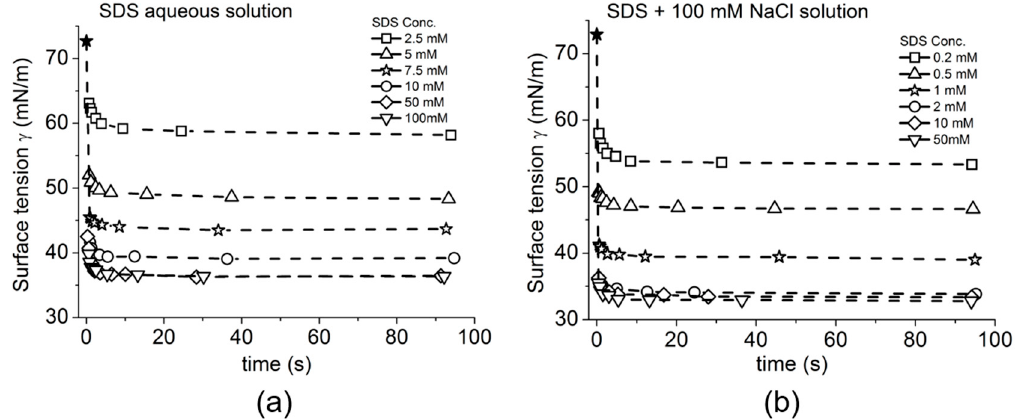
Figure 15. Dynamic surface tension of SDS in aqueous solution and in 100 mM NaCl solution measured by the MIAM at 20 ◦ C. ( a ) SDS adsorption in aqueous solutions for SDS concentrations from 2.5 to 100 mM made up in milli-pure water. ( b ) SDS adsorption in the presence of 100 mM NaCl for SDS concentrations from 0.2 to 50 mM. The solid star symbol ( (cid:70) ) shows the initial clean water or 100 mM NaCl surface tensions γ 0 , at time 0 s, obtained from independent measurements. With permission from Elsevier [8].